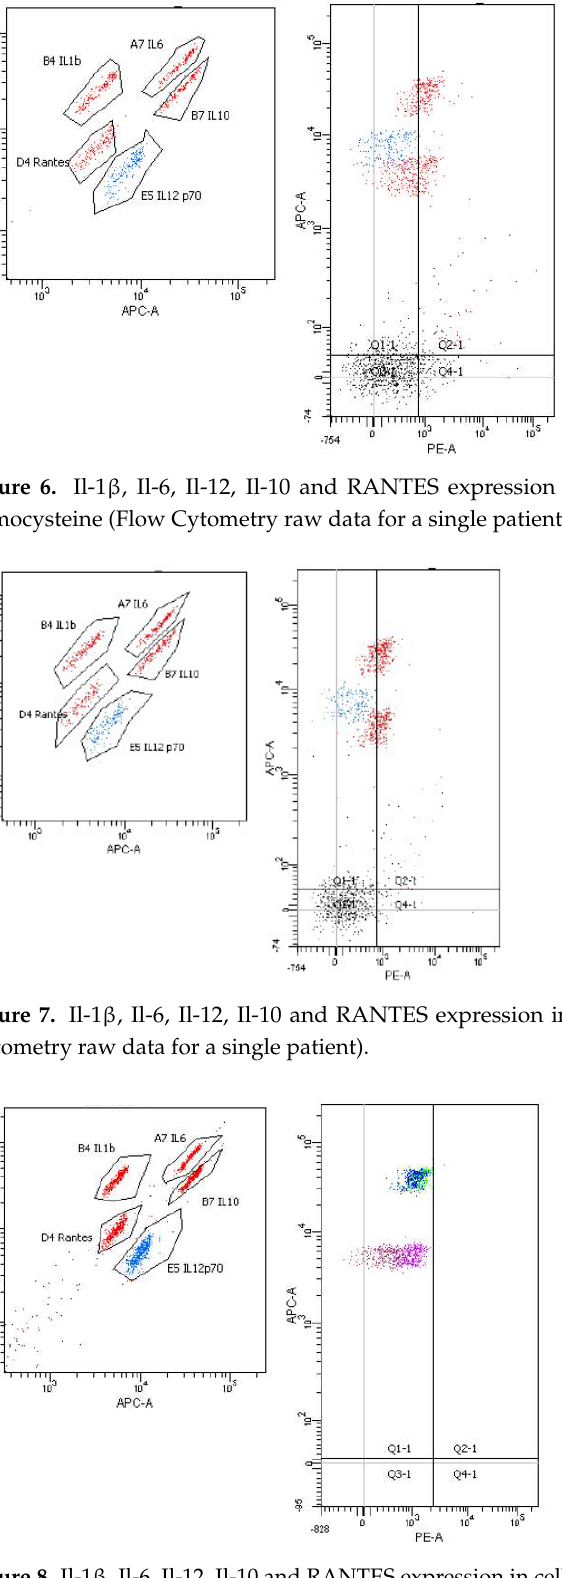
Figure 8. Il-1 β , Il-6, Il-12, Il-10 and RANTES expression in cell suspension (Flow Cytometry raw data Figure 8. Il-1β, Il-6, Il-12, Il-10 and RANTES expression in cell suspension (Flow Cytometry raw data Figure 8. Il-1β, Il-6, Il-12, Il-10 and RANTES expression in cell suspension (Flow Cytometry raw data for a single for a single patient). for a single patient). Figure 8. Il-1β, Il-6, Il-12, Il-10 and RANTES expression in cell suspension (Flow Cytometry raw data for a single patient).